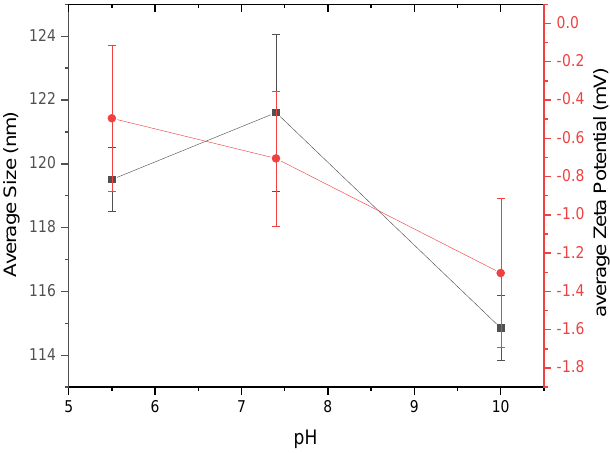
Figure 7. α -Glucan nanoparticles size (black square) and zeta potential (red circle) as a function of pH.